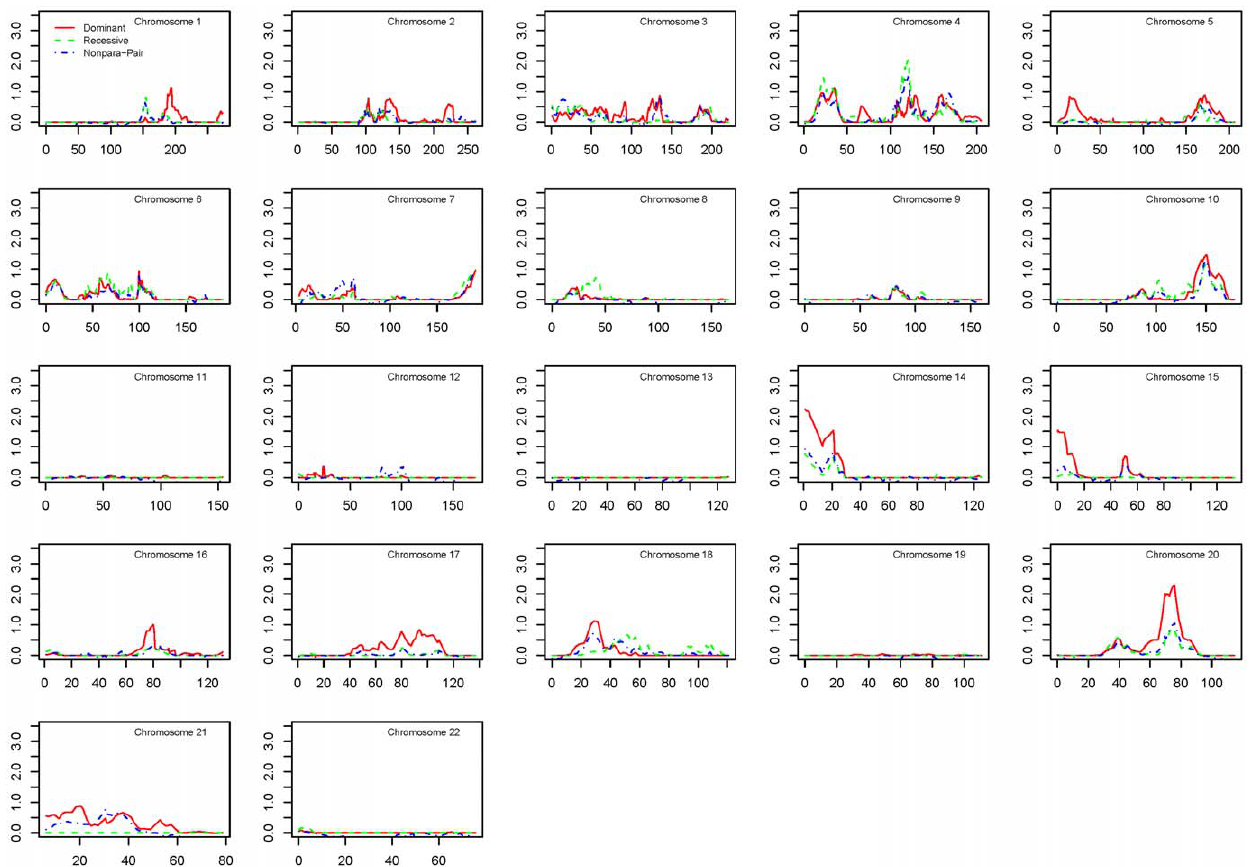
Figure 1. Linkage results for the combined dataset. Multipoint linkage scores for parametric dominant (red), parametric recessive (green), and nonparametric (blue) models are plotted for the combined dataset. Symbols indicate two-point lod scores $ 1.5 in the parametric dominant (red) and recessive (green) models.